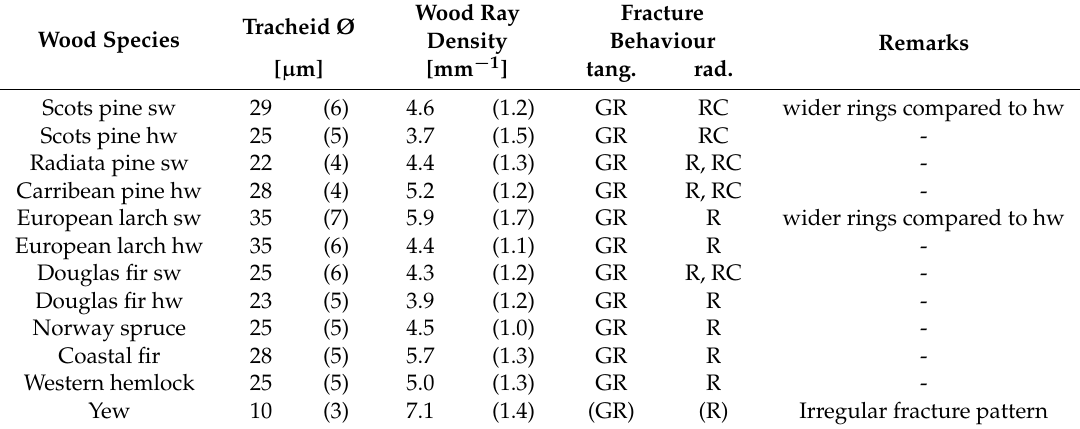
Table 3. The anatomical characteristics (tracheid diameter, ray density) and description of fractures during the HEMI-tests of different softwood species (standard deviation in parentheses).